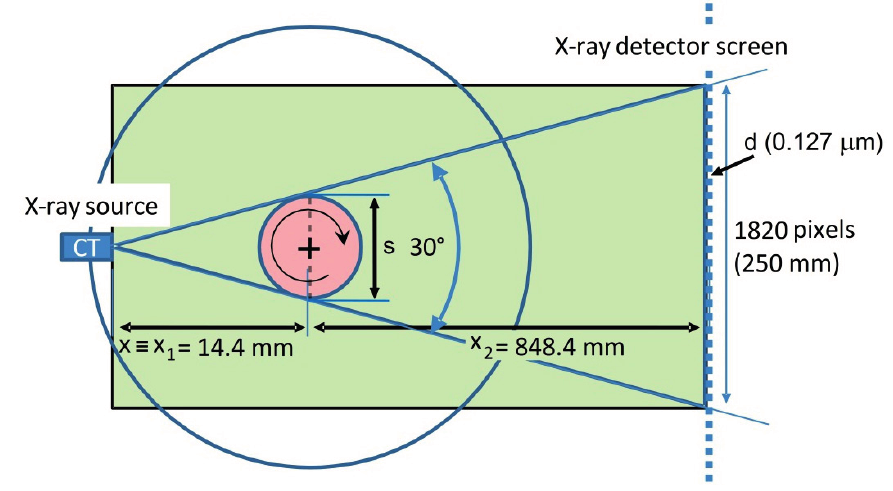
Figure 3. Schematic representation of the micro-CT setup. The distances defined in this work to achieve 4 µm spatial resolution between sample and X-ray tube and between sample and X-ray detector are